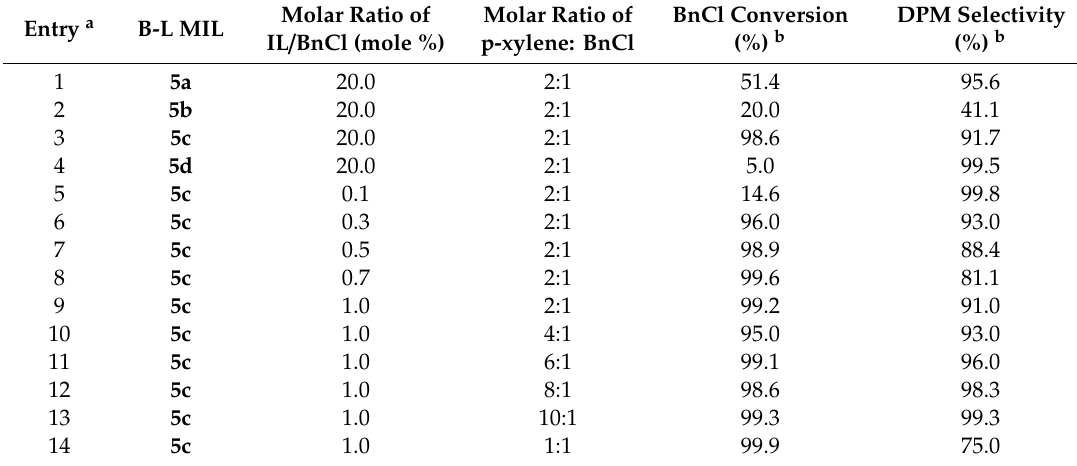
Table 1. The results of the B-L MILs 5a–d application for catalysis in the Friedel–Crafts alkylation of p-xylene with BnCl. DPM: diphenylmethane.